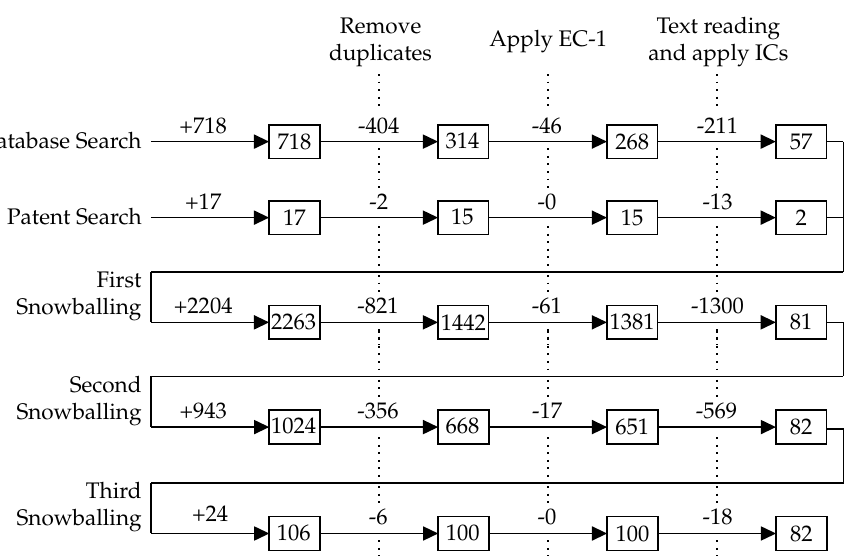
Figure 3. Number of articles in each stage of our study